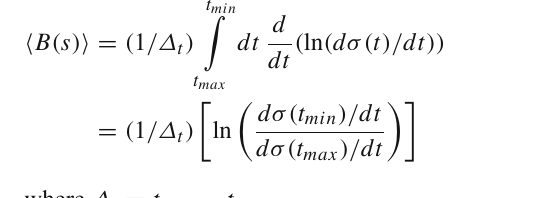
Fig. 15 Dependence on t of the slopes B ( s , t ) for pp scattering at 7 and 13 TeV and for ¯ pp scattering at 1.96 TeV